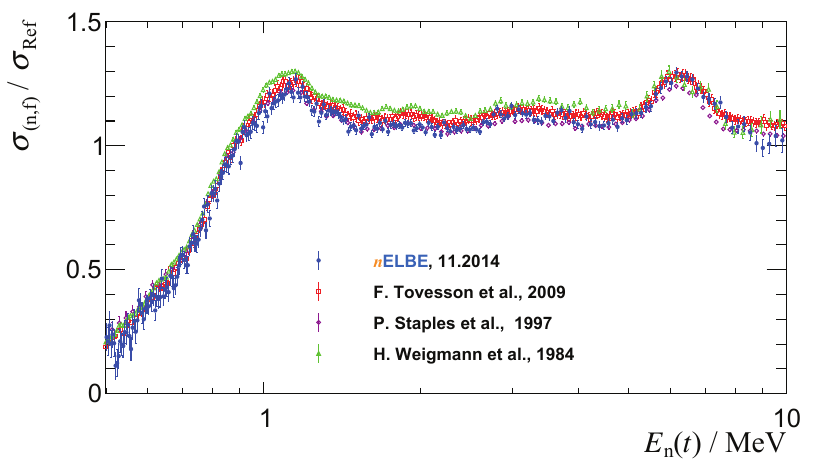
Figure 4. Neutron-induced-fission cross section of 242 Pu relative to 235 U. The n ELBE data are shown in blue together with selected EXFOR-data of Tovesson et al. [4], Staples et al. [23] and Weigmann et al. [21]. Within their uncertainties there is a good agreement of the presented data set with the data of Staples and Tovesson. Small deviations from the re-normalized (ENDF / B-V → ENDF / B-VII.1) Weigmann data are clearly